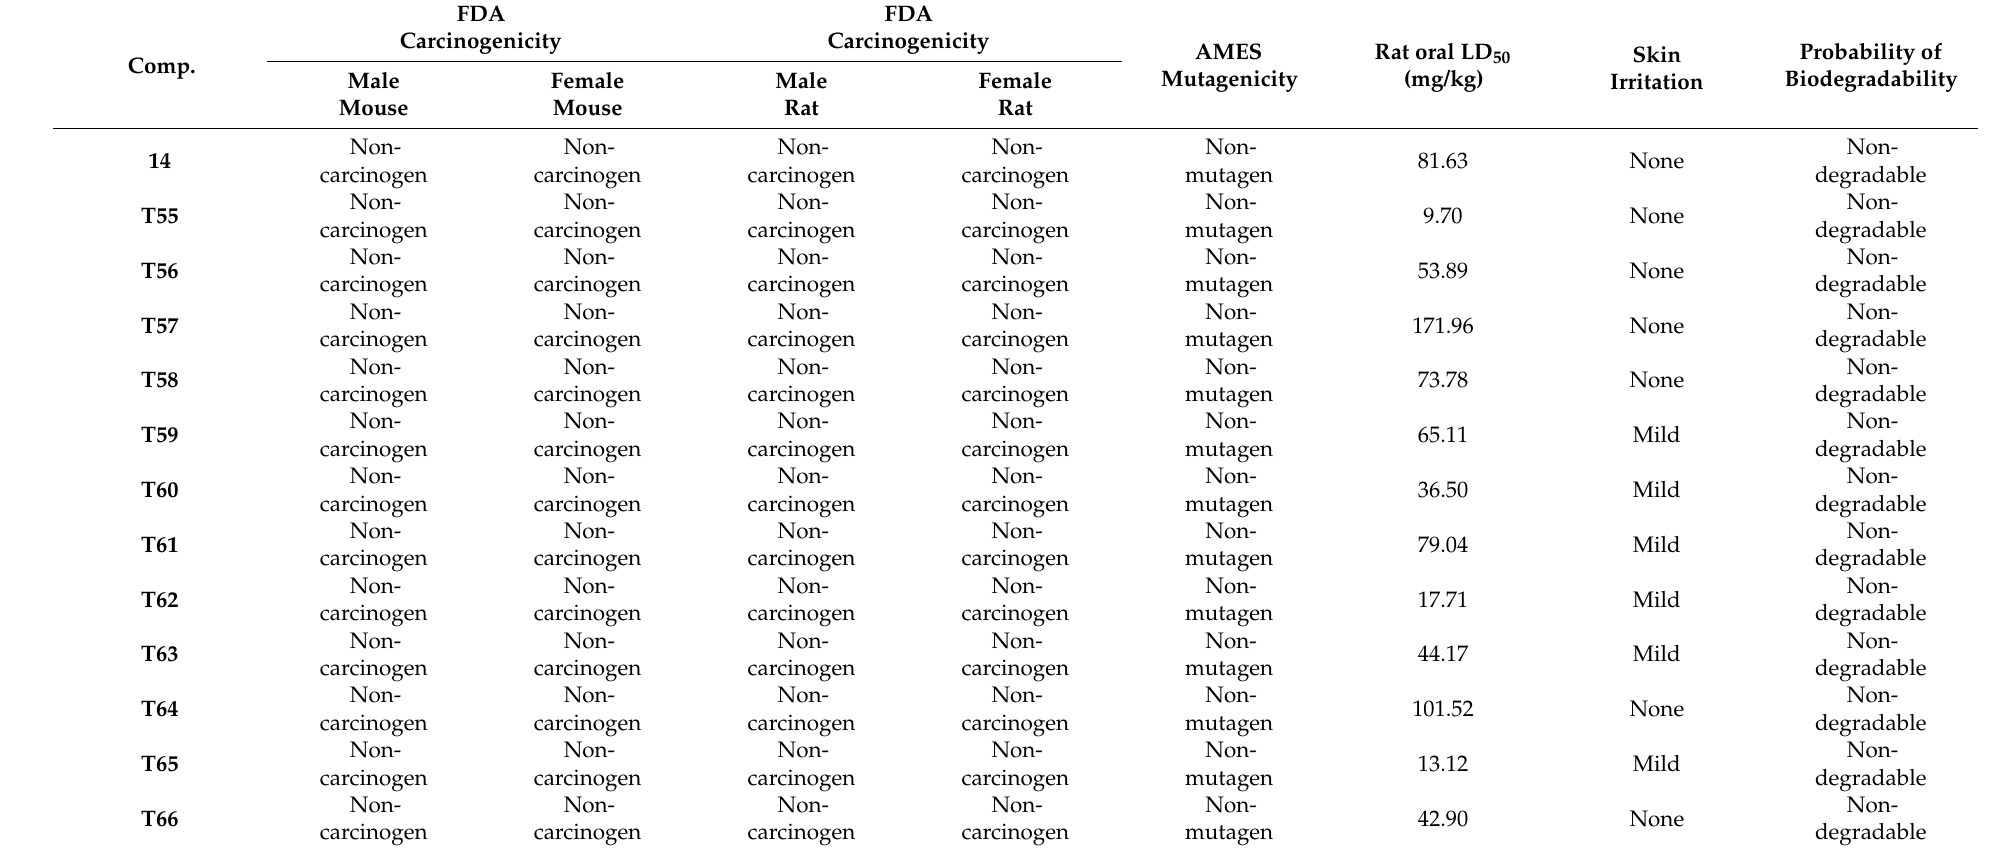
Table 8. Toxicity results of the newly designed inhibitors and the most potent template molecule.